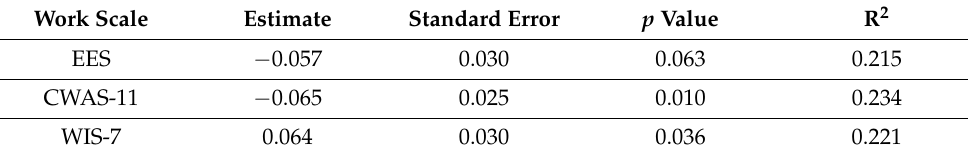
Table 6. Multivariable linear regression of work scales to predict 3 MT